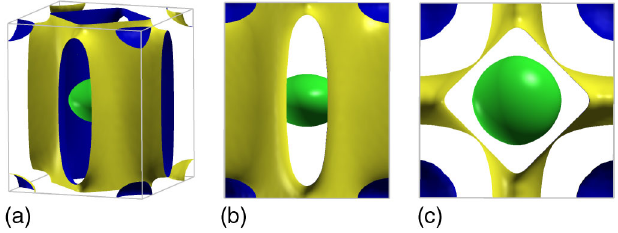
FIG. 5. LDA Fermi surface of pristine NdNiO 2 . (a) 3D view, (b) view along k , and (c) view along k x